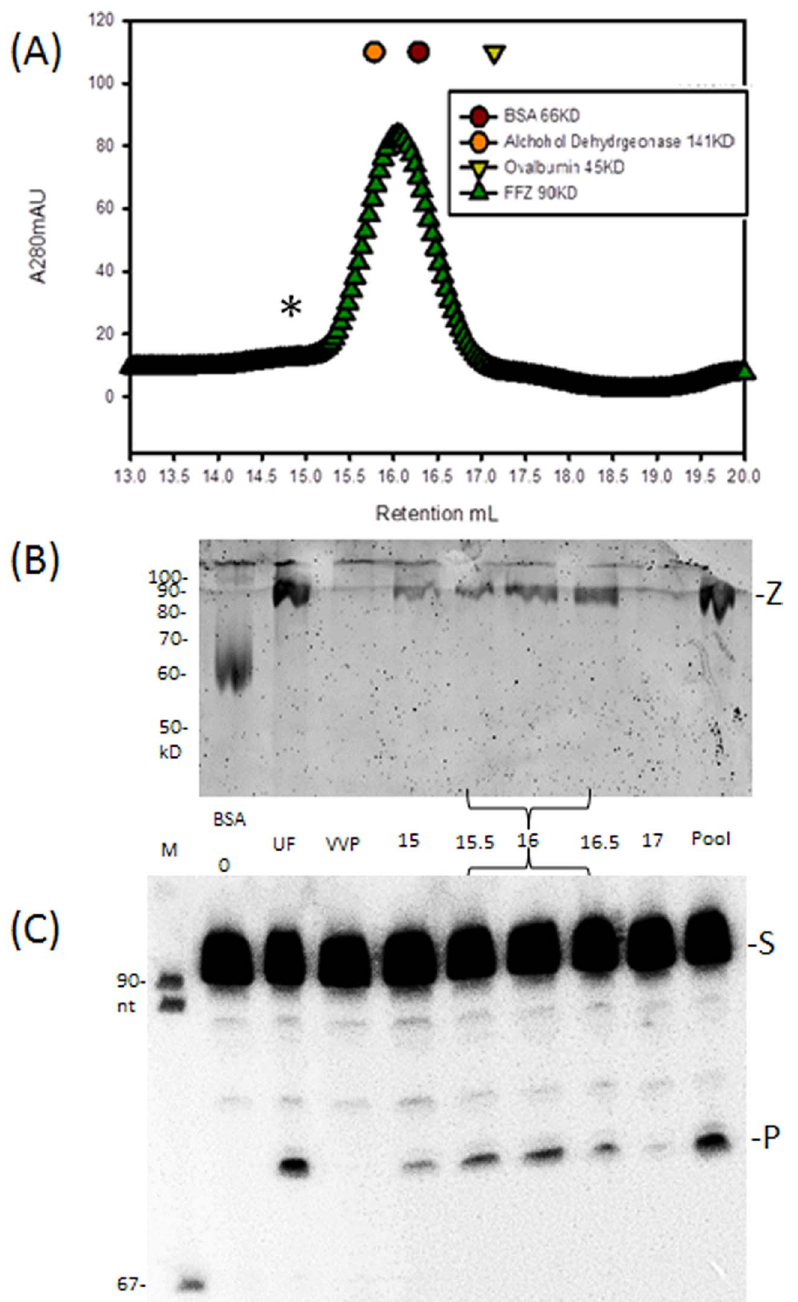
Figure 2. tRNase Z purifies as a monomer. (A) Affinity purified D. melanogaster tRNase Z was separated by SEC using a Superose 6 10/300 GL column on the Akta Purifier 10 platform (GE Life Sciences). Symbols above the absorbance profile indicate elution peaks for Ovalbumin (45 kD), BSA (66 kD) and Alcohol Dehydrogenase (141 kD). tRNase Z (green triangles) chromatograms as a monomer true to its , 84 kD molecular weight. * identifies a shoulder in the chromatogram coinciding with expected position of the tRNase Z L dimer which is apparently low in quantity and enzyme activity. Lines beneath axis indicate peak fractions. B) Protein gel. UF: Unfractionated tRNase Z. Pool – peak fractions were pooled and concentrated. C) Processing assay of three peak fractions compared with UF indicates that gel filtration improves enzyme specific activity. Each fraction was incubated with end-labeled substrate for 15 min. and electrophoresed on a denaturing polyacrylamide gel. S, P at right designate the 90 nt D. melanogaster pre-tRNA Arg substrate and 73 nt product, respectively. Lane 0: no processing control. doi:10.1371/journal.pone.0066942.g002 from an internal methionine (M 24 AAT) that is taken to be the throughout. Removing the His-tag using rTEV protease (Invitro- translation start for the nuclear form of fruit fly tRNase Z, two gen) leaves a 7 residue leader (GAMDPEF) which was added to residues before the predicted amino end of the mitochondrial form the tRNase Z for interpretation of masses in the spectra. after import and cleavage [16], and is thus numbered M 1